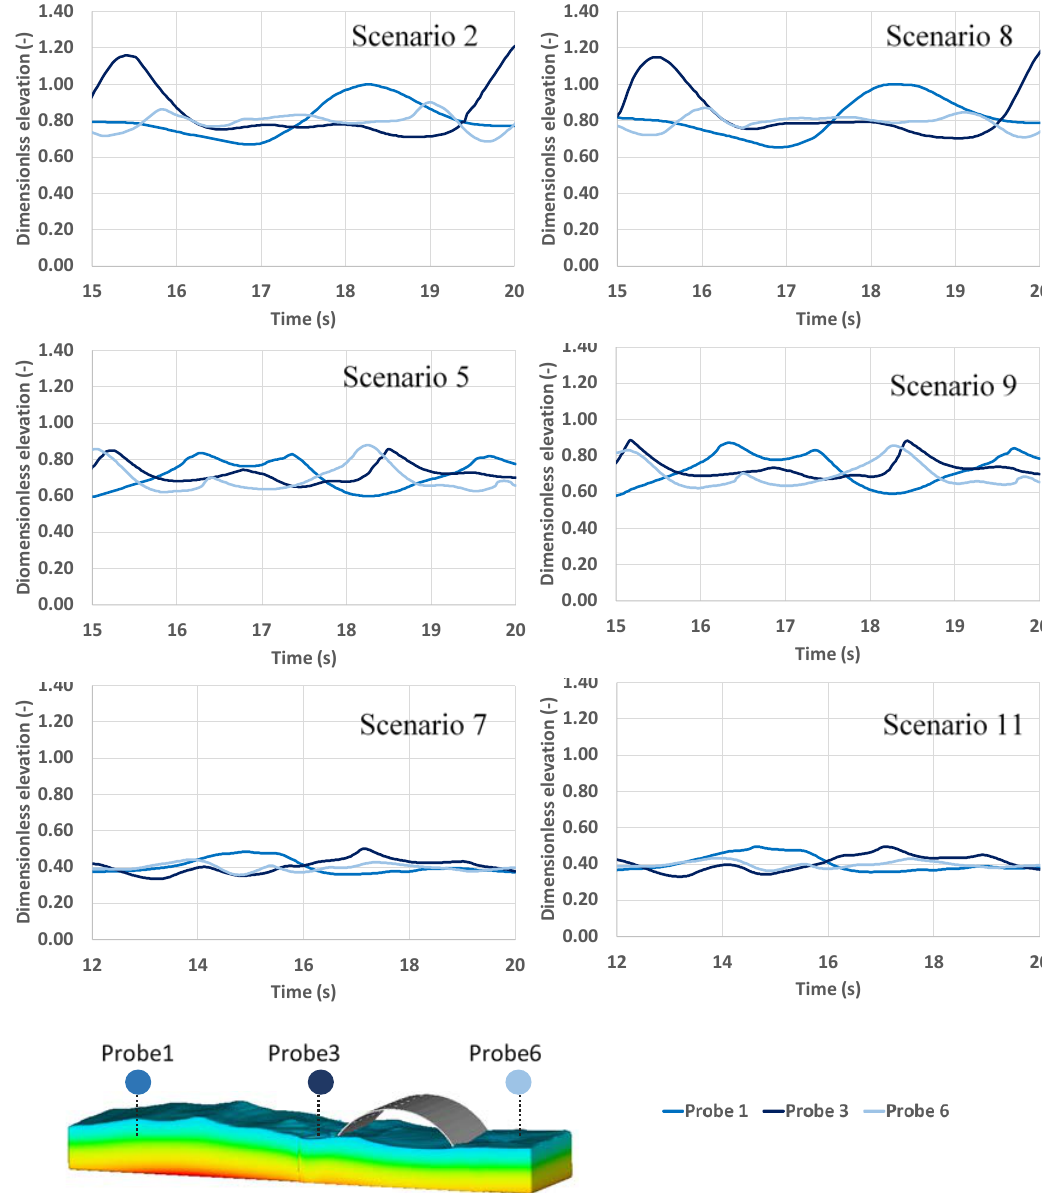
Figure 8. Water surface elevation at different probes for scenarios 2, 5, 7, 8, 9 and 11 (the elevations were dimensioned using the maximum value at probe 1 for scenario 2).